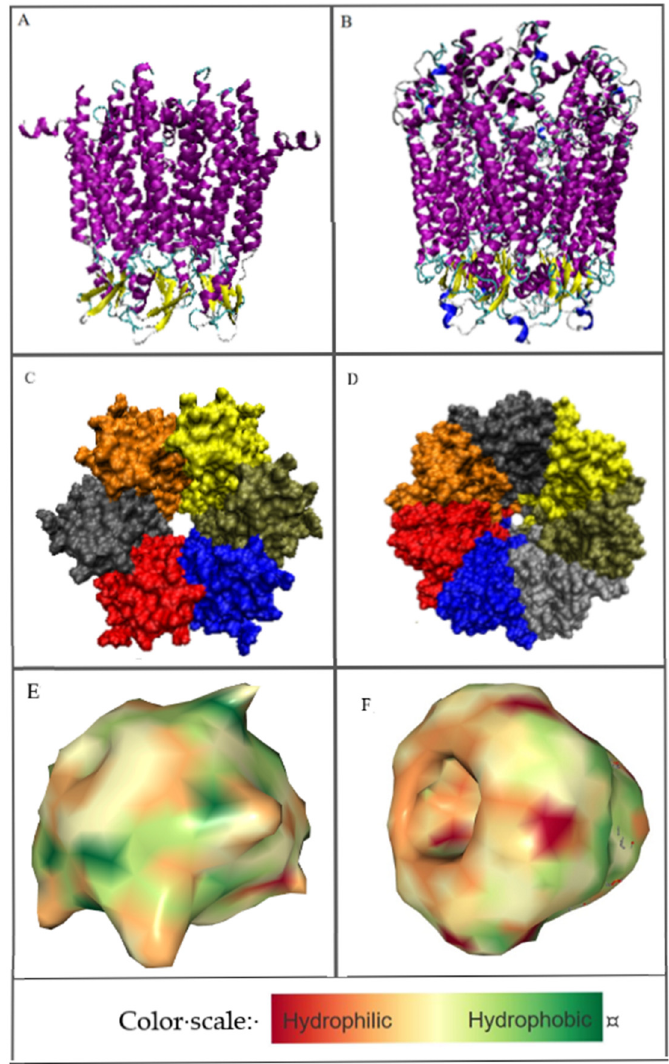
Figure 2. 3D structure of: ( A )—connexin’s hemi-channel, ( B )—pannexin’s channel with secondary structure distinguished: yellow—Beta-sheet, magenta—transmembrane helices, dark blue—external helices, green—random coil. The beta-sheet is in the outer membrane part that is exposed to the outside of the cell. ( C , D ) represent the differences in channel construction as well as the six and 7-fold symmetry. ( E , F )—hydrophobicity visualization: connexin and pannexin respectively. Images ( E , F ) created by NGL Viewer: Rose et al. (2018) NGL viewer: web-based molecular graphics for large complexes. Bioinformatics doi:10.1093/bioinformatics/bty419, and RCSB PDB. ( A , B )—orientation of the molecules: Top—intra-cellular area, bottom—extra-cellular area; ( C , D )—orientation from the point of view of the intra-cellular area—symmetry axis perpendicular to the plane of the figure; ( E , F )—side view arbitrarily selected to visualize the shape differences of the compared complexes. The visualization given in Figure 2A,B identifies the membrane helices (magenta) in both complexes as well as the part of the complex directed outside the membrane